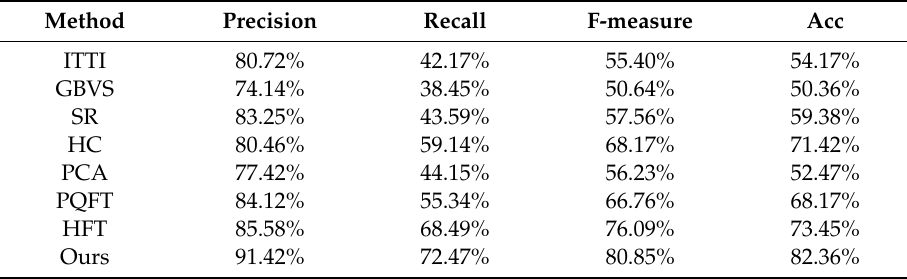
Table 1. Comparison of related numerical indicators for di ff erent